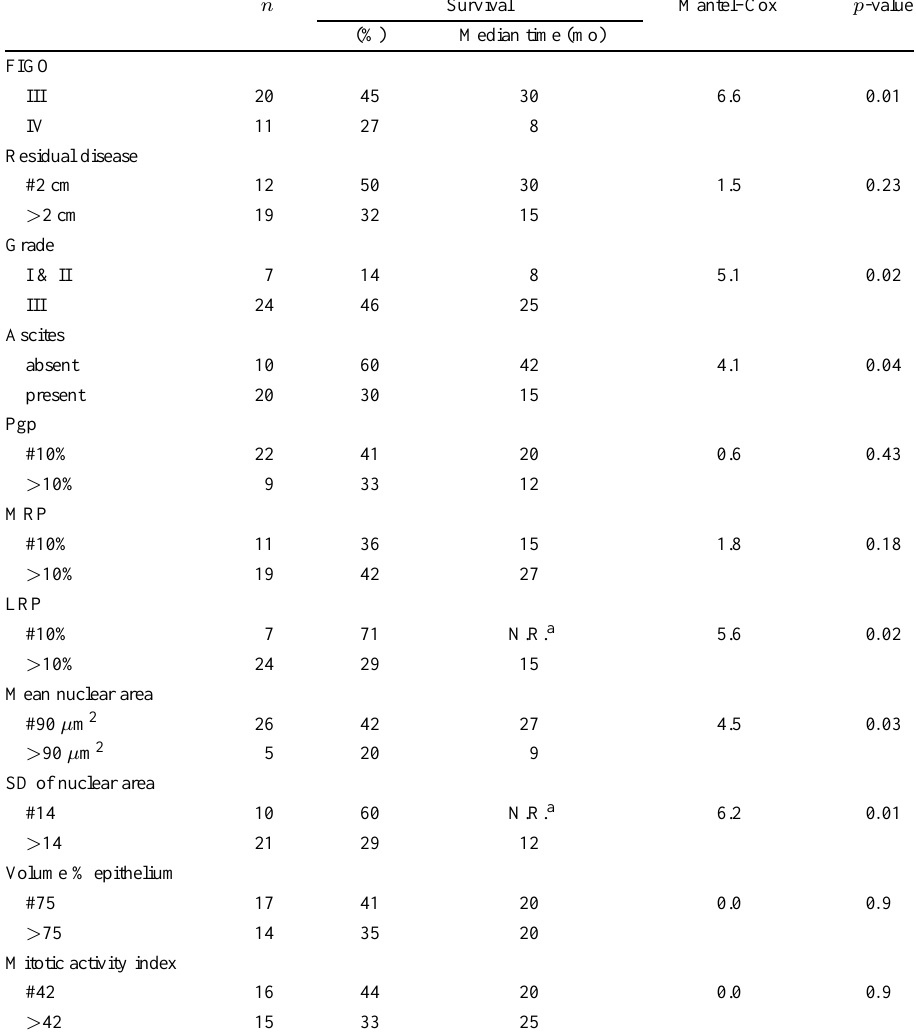
Results of univariate survival analysis in 31 patients with advanced ovarian cancer (MC = Mantel–Cox